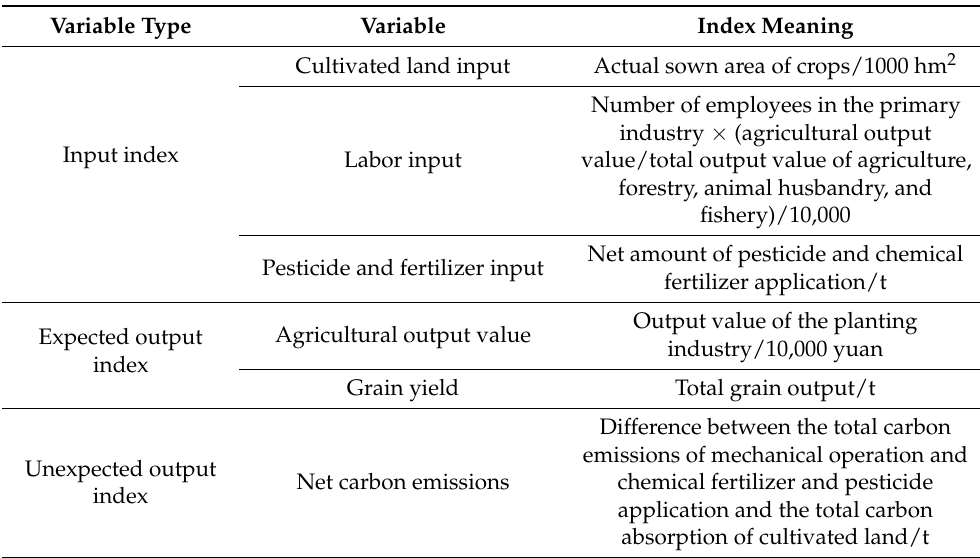
Table 1. Evaluation index system of the